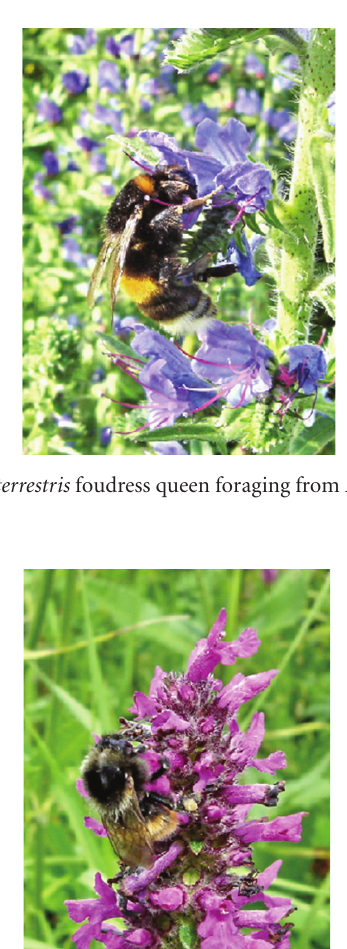
Figure 7: B. (Ps.) vestalis female feeding on Ajuga reptans.